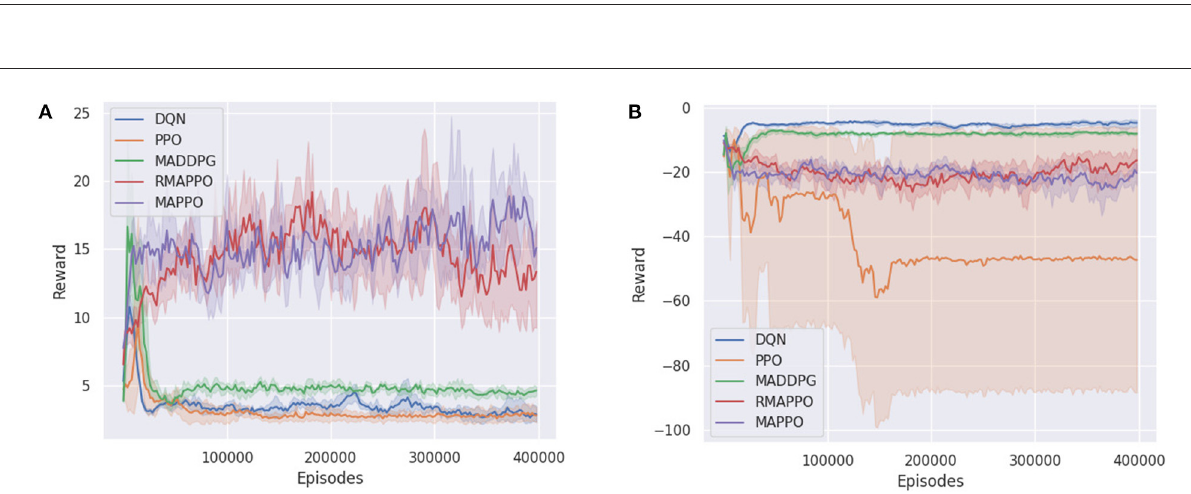
FIGURE6 Training curves of various algorithms in the Simple Tag, a Predator-Prey environment. (A) Shows the reward of a predator (all predators obtain the same reward), (B) shows the reward of the